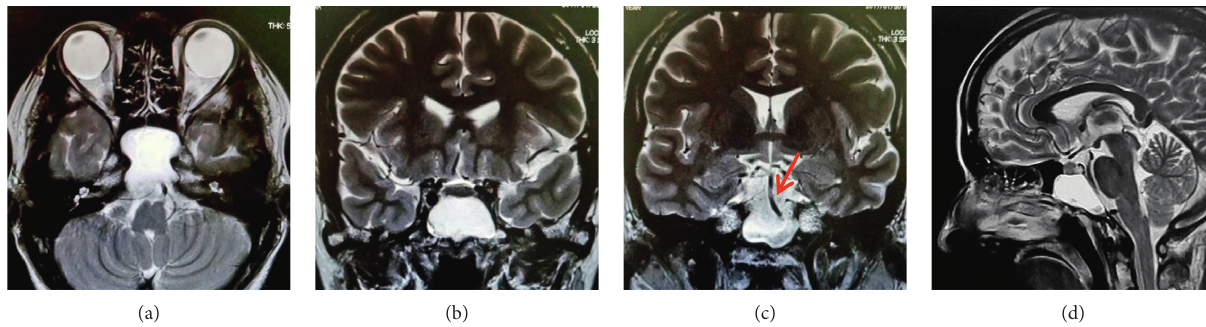
Figure 2: Noncontrast magnetic resonance T2-weighted imaging of the paranasal cavity at the initial diagnosis. (a) Axial, (b, c) coronal, and (d) sagittal views. The basilar artery located adjacent to the cyst (c) is indicated with the red arrow, and the cyst located adjacent to the brainstem (d) is indicated with the white arrow; however, the signal intensity of the lesion’s contents is determined to be different from that of cerebrospinal fluid, therefore suggesting a primary cyst.